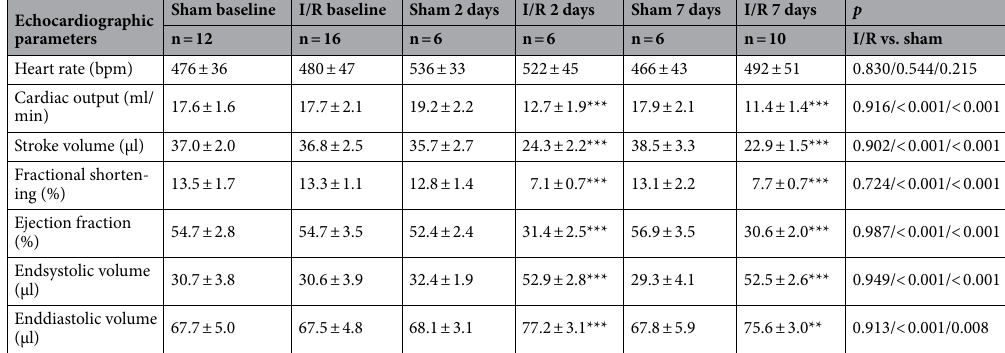
was the case for atrial or atrioventricular conduction (Table 2). VRP correlated with rate-corrected QT and rate-